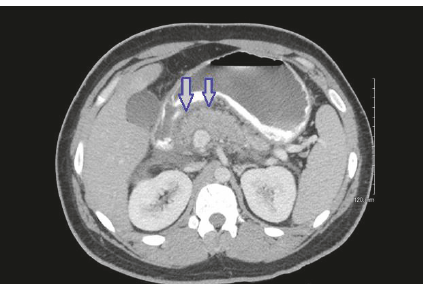
Figure 1: Peripancreatic inflammatory changes consistent with acute pancreatitis